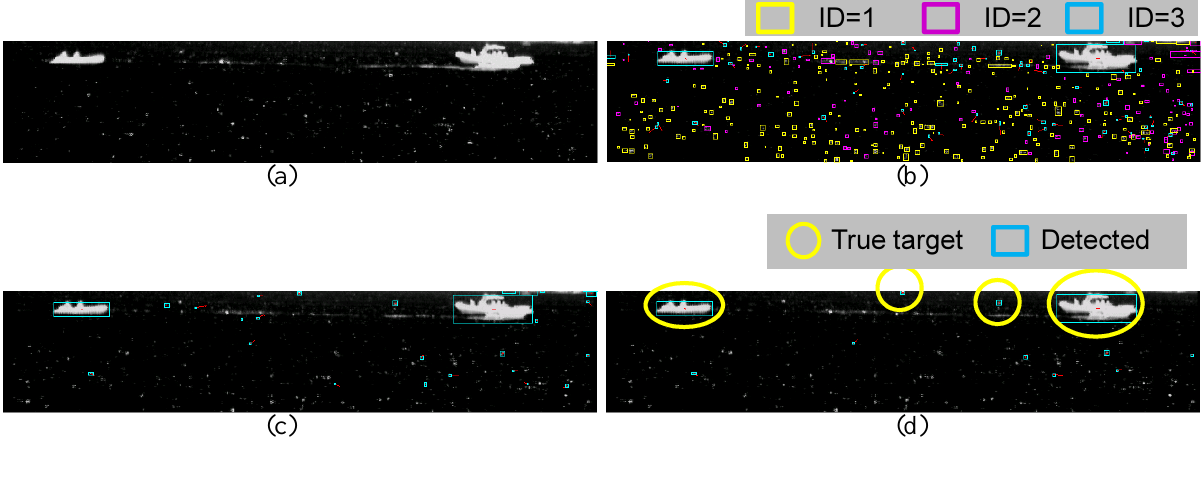
Example of the target detection flow for a sea regional infrared image.